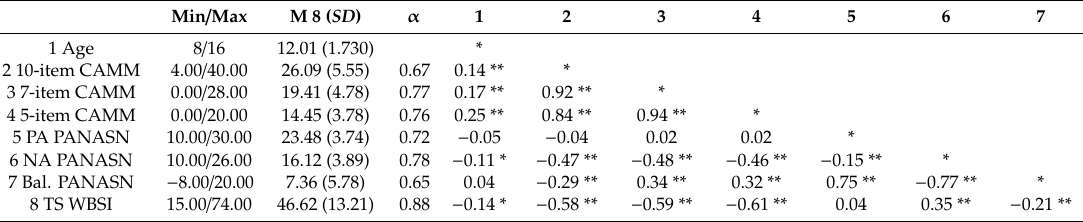
Table 2. Descriptive Statistics for every single version of Spanish CAMM ( n = 678). Predict validity study (correlations) was conducted using Andalusian sample ( n = 318). Cronbach’s alpha reliability is reported (alpha). No significant di ff erences between male and female participants for all measures were found. In bold significative